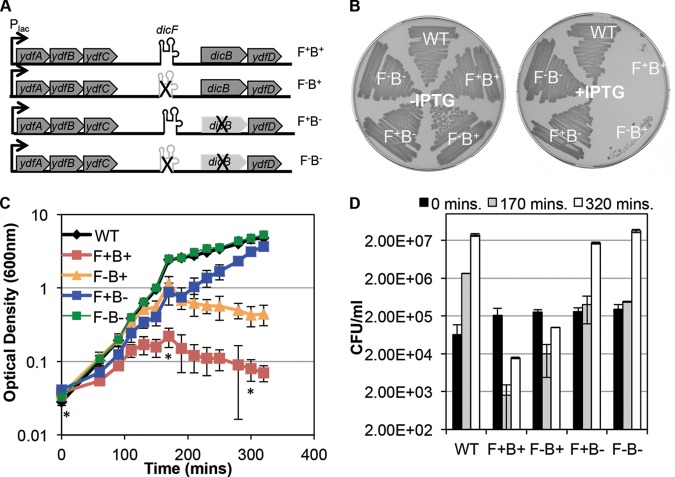
The dicBF chromosomal locus and roles of DicF and DicB in cell physiology. (A) Cartoon illustrating the chromosomal arrangement of the dicBF locus with the specific deletions depicted. A Plac promoter was used to replace the native dicBF promoter (F+B+) in an otherwise wt strain. Gene dicF or gene dicB was deleted in this context to create an F−B+ strain or an F+B− strain, respectively. Both genes were mutated in this context to make an F−B− strain. (B) The wild-type strain (WT) and the four constructs described for panel A were streaked on LB plates with or without 0.5 mM IPTG. (C) The strains described above were grown in liquid LB medium, 0.5 mM IPTG was added at time 0, and growth was monitored over time. (D) The viability of the strains described for panel C was measured at the time points indicated by asterisks.